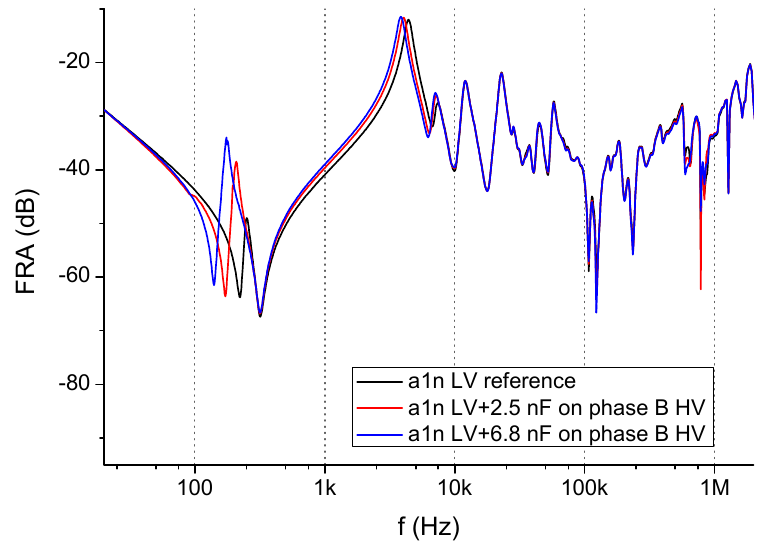
Figure 10. FR of LV phase a of 250 MVA, 400/110/30 kV autotransformer with additional capacitances installed on HV phase B.